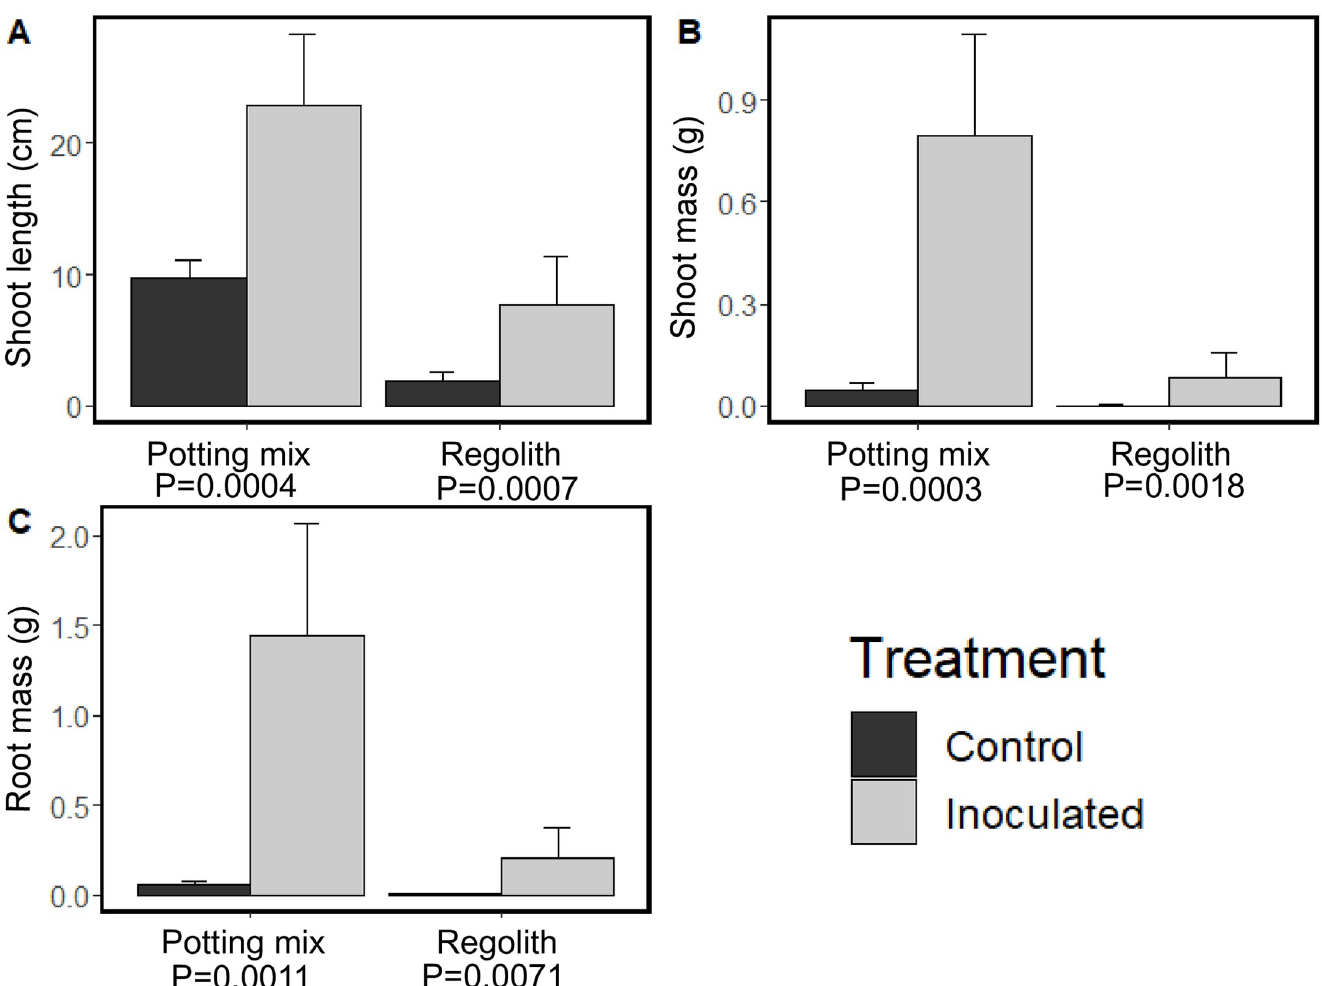
Fig 2. Sweet clover ( Melilotus officinalis) shoot length (A), shoot biomass (B), and root biomass (C) as measured either above or below the root sheath. Error bars represent standard error of the mean. P-values derived from one-way ANOVA analyses.